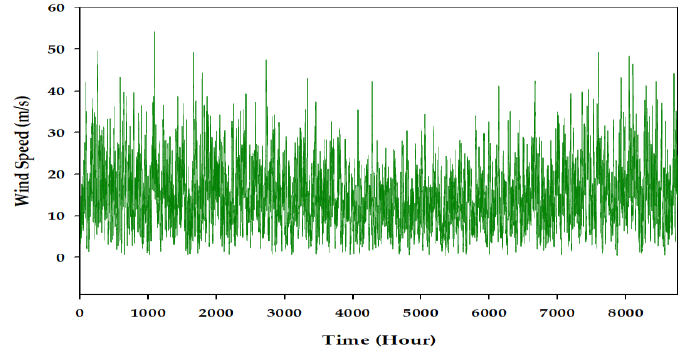
Figure 4. Wind speed.